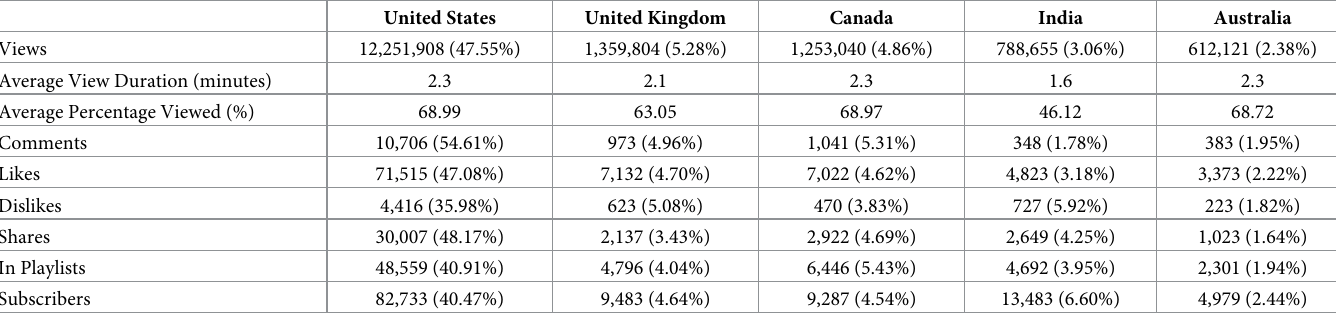
Table 4. User engagement by geography (top 5 view count